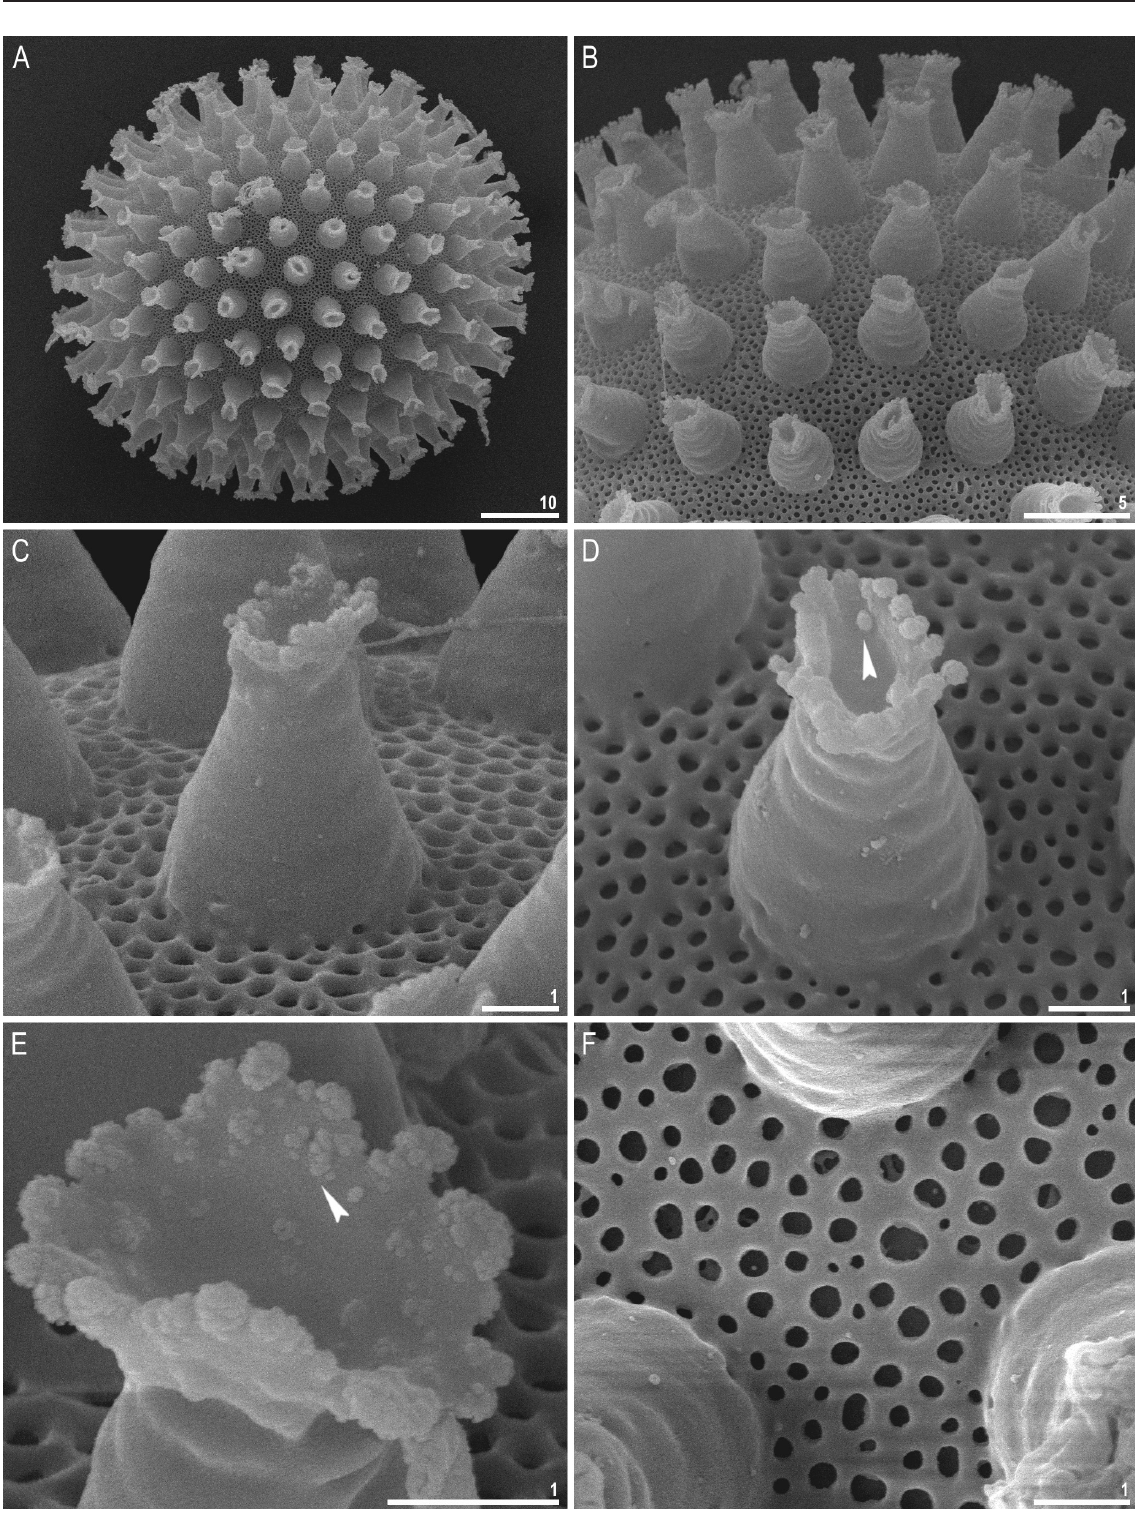
Fig. 7. Macrobiotus noongaris sp. nov., egg chorion morphology seen in SEM (IZiBB). A . Entire egg. B . Magnification of the egg surface. C–D . Details of the egg processes. E . Terminal disc. F . Details of the reticulation between egg processes. Arrowheads indicate scattered granulation on the terminal disc surface. Scale bars in